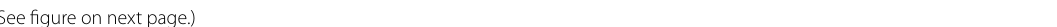
right(See figure on next Fig. 12 The figure shows the top 40 features used by the ML algorithm, sorted by their average impact on the final prediction for the calibrated value, as was calculated by the SHAP method. This was evaluated for the X, Y, and Z components of the measurements in the satellite frame where each feature’s contribution consists of the contribution to each component, distinguished by color. Note the different scale of the features on the left and